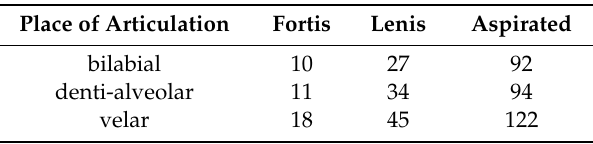
Table 1. VOT (in ms) of Korean stops as produced by the female model talker in participants’ Korean textbook (Seoul National University Language Education Institute 2010). All measures represent VOT of stops in utterance-initial position before the low vowel /a/.